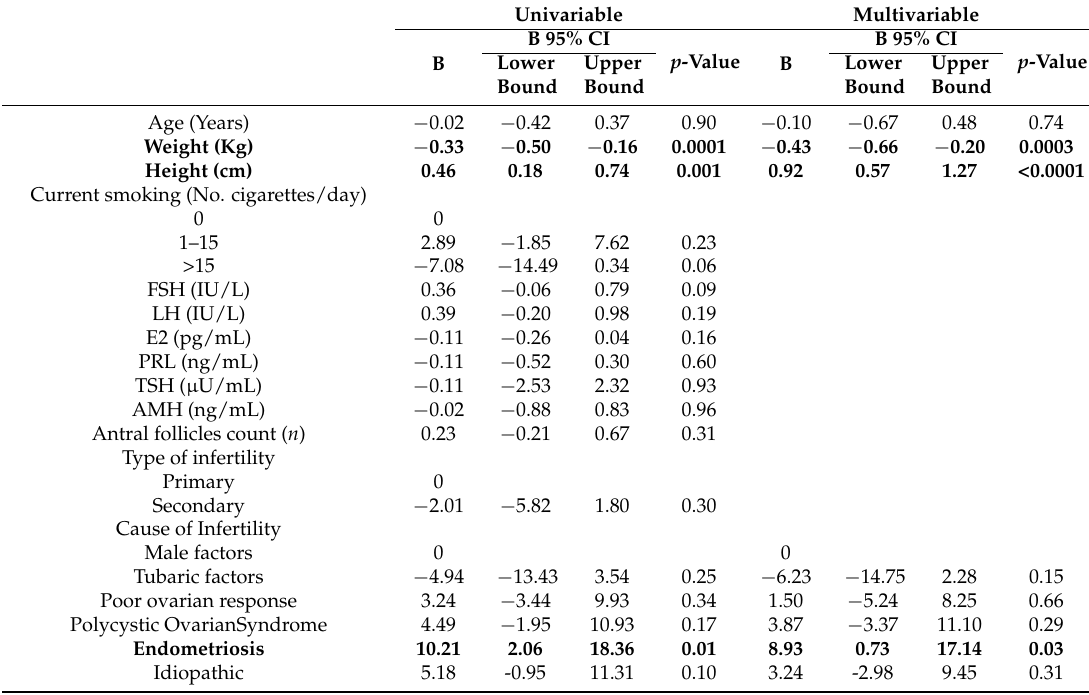
Table 3. Linear regression analysis results for measured variables as determinants of vitamin D status.